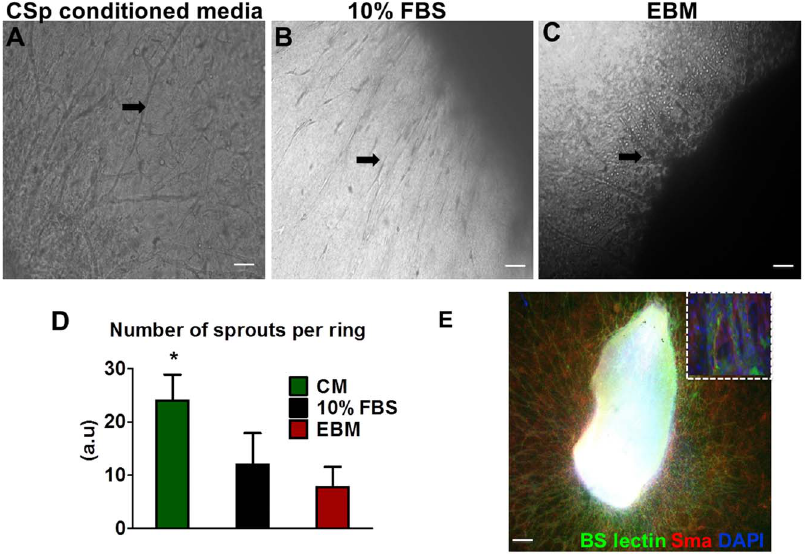
Figure 4. Aortic ring sprouts. Representative phase contrast images from aortic rings embedded in collagen matrices 9 days post treatment with (A) CSp conditioned media, (B) 10% FBS culture media and (C) endothelial basal media. (D) Quantification of sprouts on day 9 under phase contrast microscopy. Arrows point at the new sprouts. (E) Immunofluorescence of the CSp conditioned media treated aortic ring reveals the phenotype of the de novo formed microvessels. Inserted photo is a high power field image of the immunostained microvessels for BS-lectin and smooth muscle actin. Three different experiments per group were evaluated (Scale bars 10 m m). Data are mean 6 SD. " p , 0.05 control vs. MI + CSp.